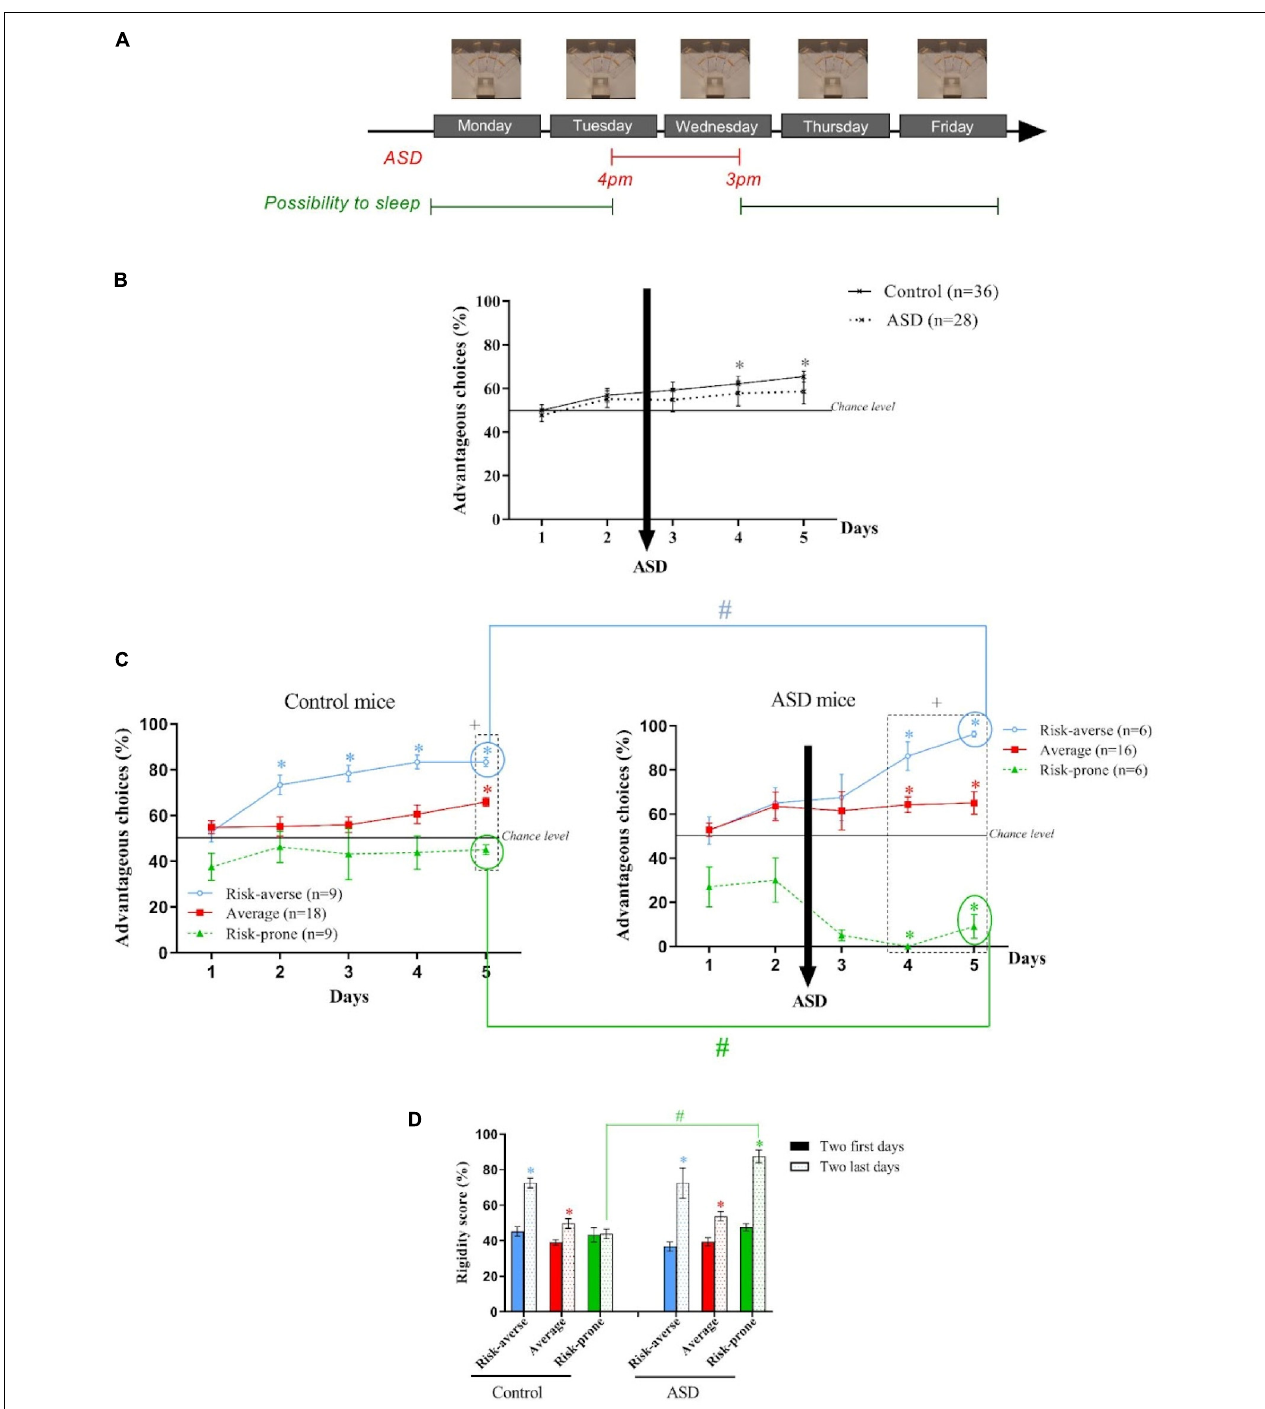
FIGURE 3 | (A) Protocol of the Acute Sleep Debt (ASD) during the Mouse Gambling Task (MGT). (B) Evolution of the preferences of the animals as a group during the MGT for the control mice and the ASD mice. ∗ p < 0.05 from chance level. (C) Evolution of the preferences of the risk-averse, average and risk-prone animals from days 1 through 5 in the MGT for the control and ASD mice. ∗ p < 0.05 from chance level. + p < 0.05 differences from the three groups. # p < 0.05 differences between the three groups (Kruskal Wallis). (D) Rigidity score of the risk-averse, average and risk-prone animals at the beginning and the end of the MGT for the control and ASD mice. ∗ p < 0.05 difference between the first two and last days. # p < 0.05 differences between control and ASD mice. Adapted from Pittaras et al.,